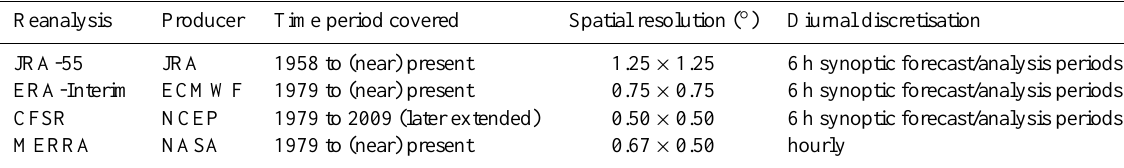
Table 1. Reanalysis data sets utilised for comparative climate